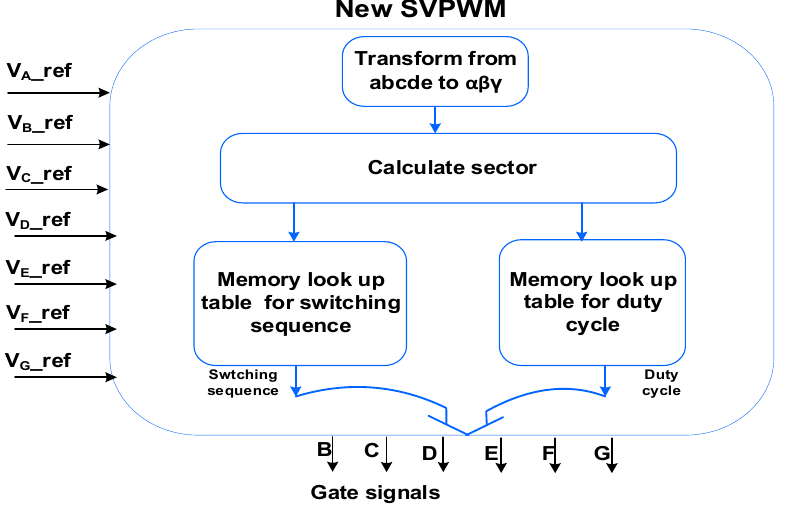
Figure 9. Flowchart illustrates the implementing the new SPVPWM after losing phase ‘A’. Firstly, outputs of the controllers (V_ref) are used to determine the sector no based on Table 1. Table 1. identifying the sector.